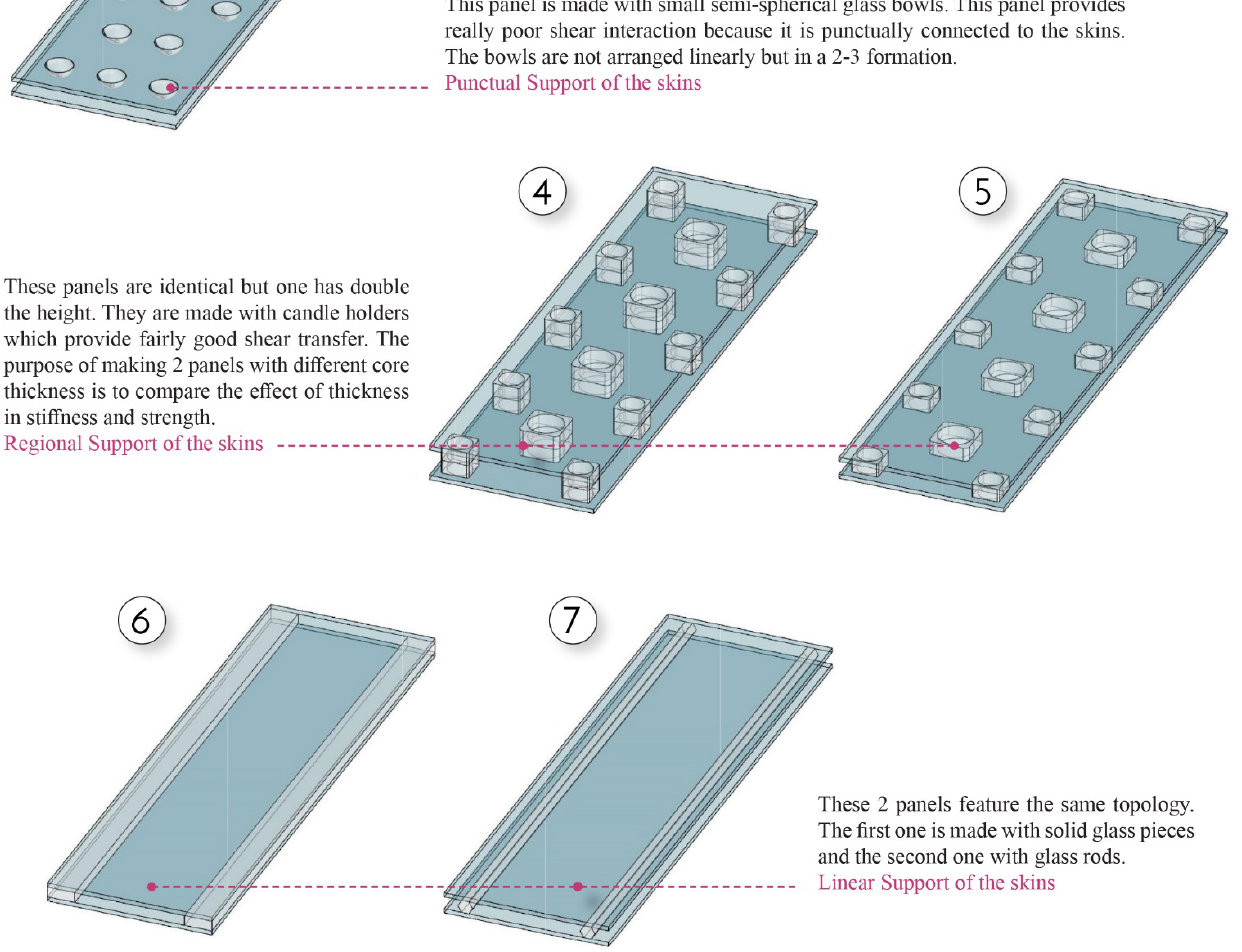
Fig. 4: The 7 specimens that were designed, calculated and